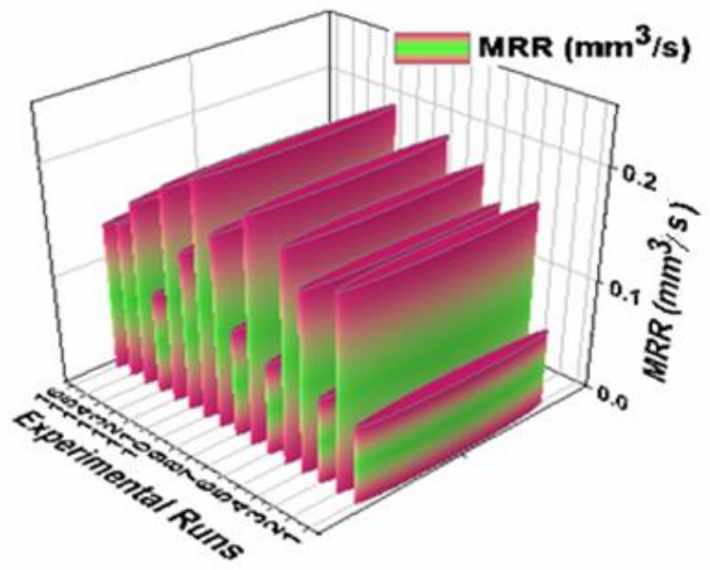
Figure 7. 3D bar plot of experimental vs. material removal